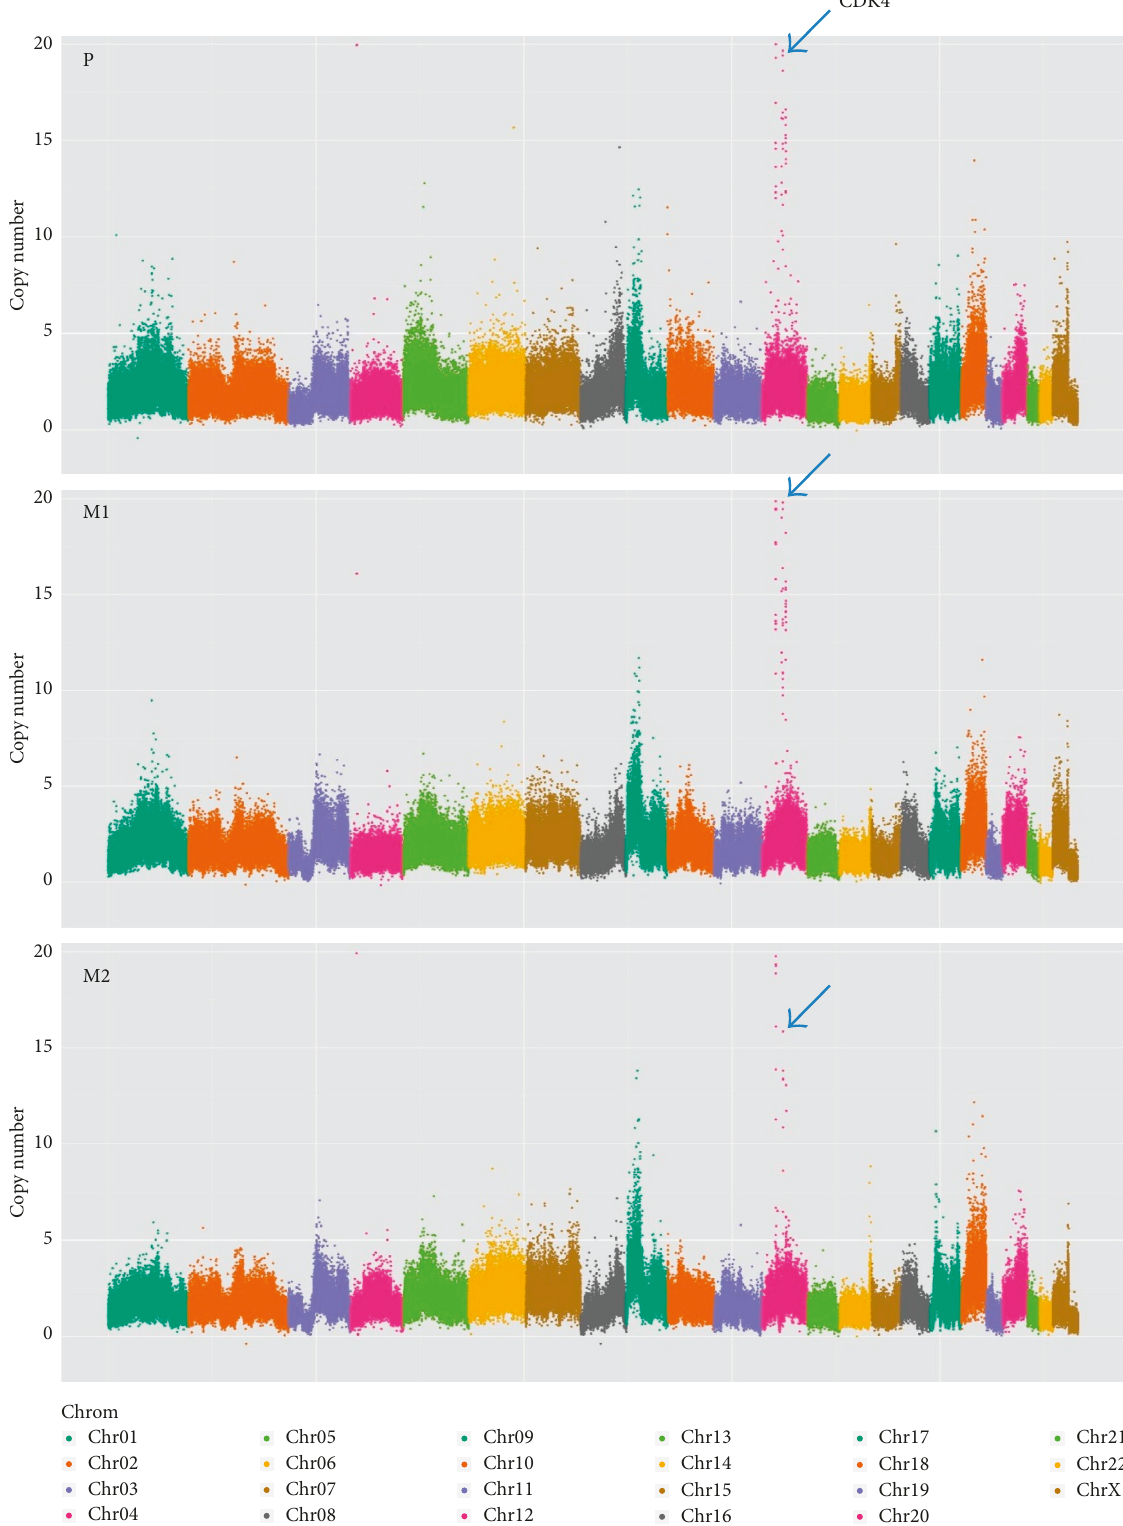
Figure 1: Comparison of copy number plots from three tumour samples of patient #59. The genome is represented on the x -axis and chromosomes are delineated by changing colours starting with chromosome 1 on the left. A persistent CDK4 amplification in all three samples is shown. P, primary tumour; M1, metastasis #1; M2: metastasis